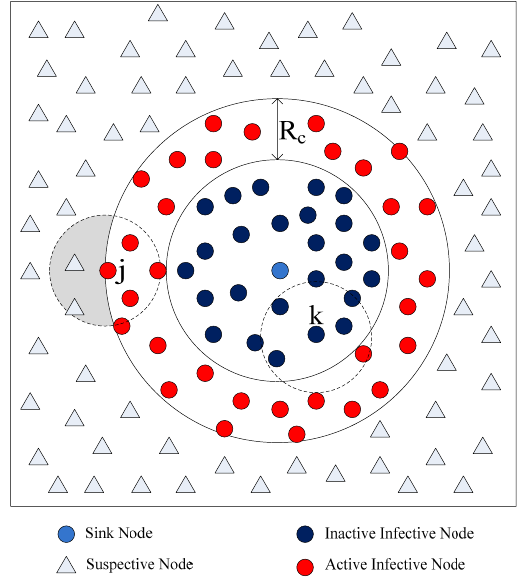
Figure 3. The message packet’s spreading process in a network with basic flooding. The periphery of the infected nodes is shown by the full curve. The communication areas of nodes are shown by virtual